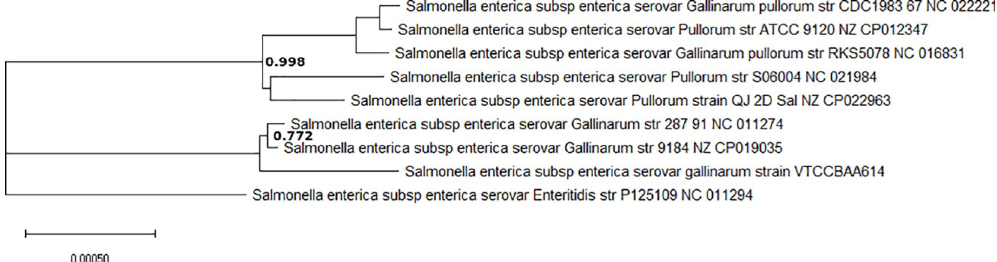
Fig 4. Unrooted phylogenetic tree showing taxonomic positions of the investigated Salmonella strains constructed by EDGAR on the basis of core genome set. Branch support values that were lower than the maximum values of 1.0 are shown at the respective branches.